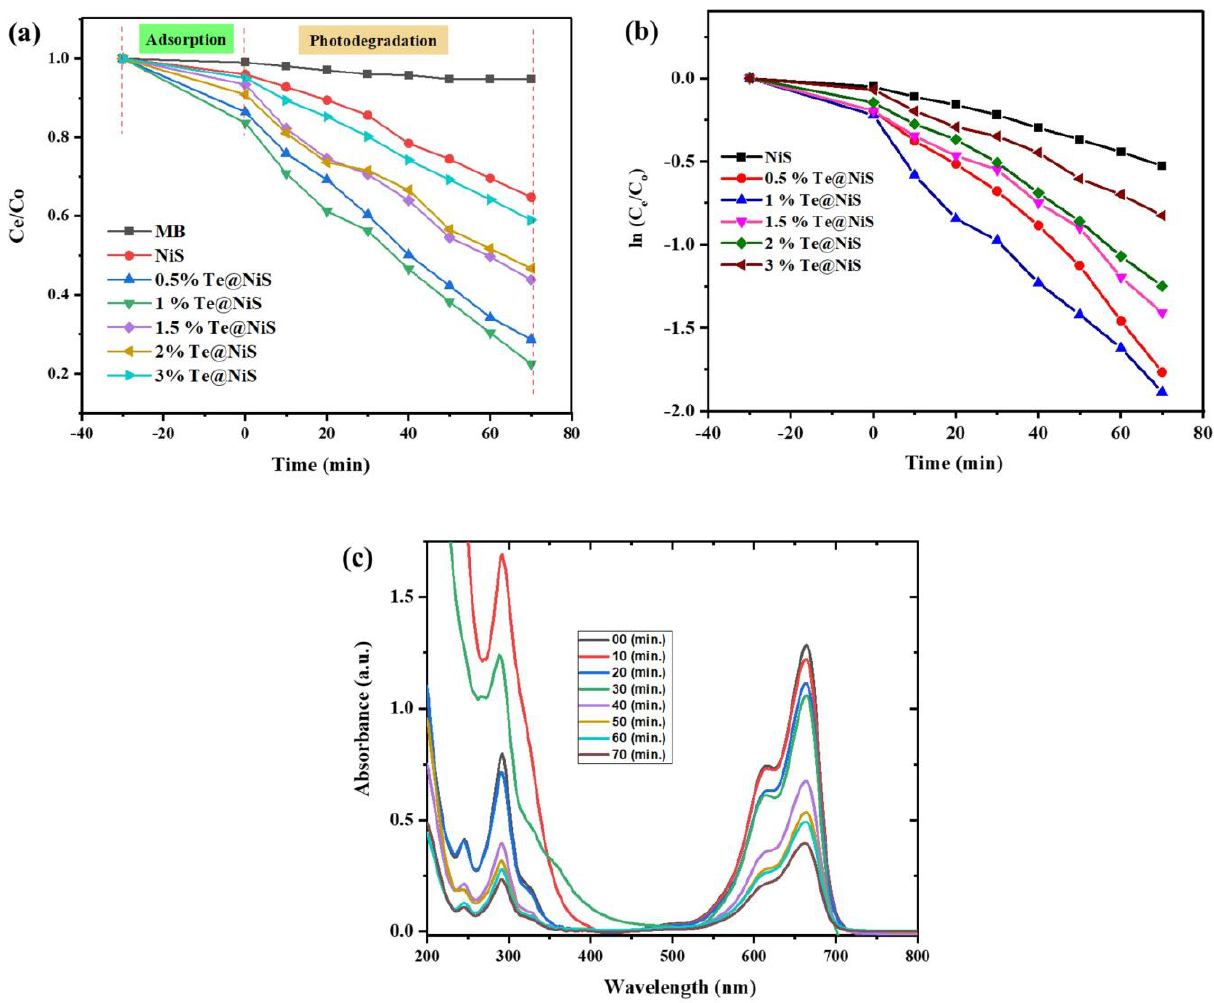
Figure 7. Degradation efficiency ( a ). Kinetic study ( b ). Effect of time on degradation of MB